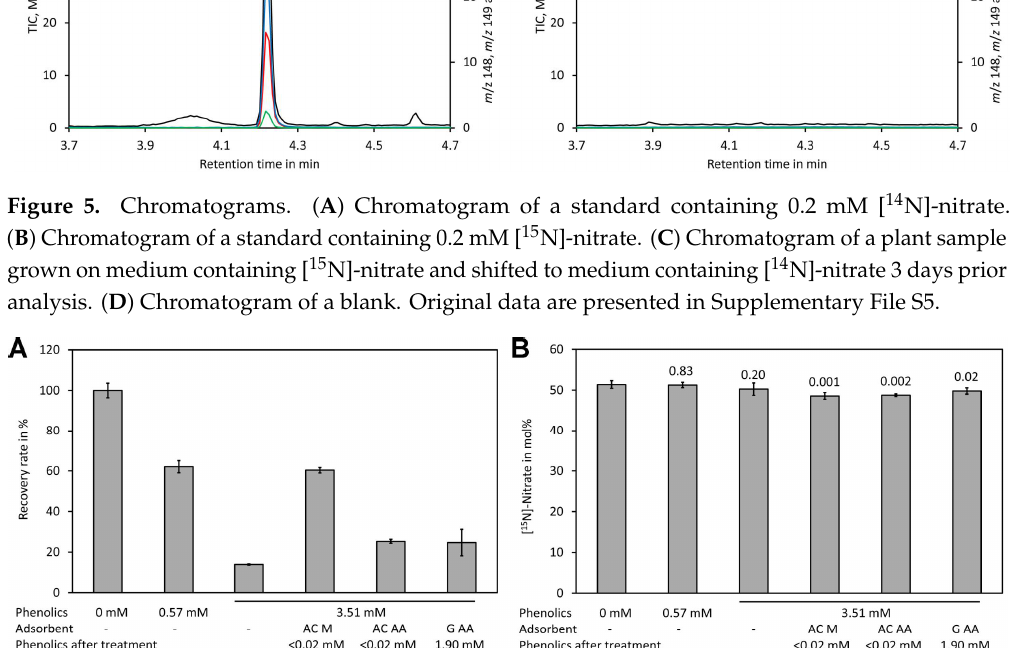
Figure 6. Matrix e ff ect of plant leaf extracts. ( A ) Samples containing di ff erent levels of phenolic compounds (measured in mM ferulic acid equivalents) were spiked with a mixture containing [ 14 N]-nitrate and [ 15 N]-nitrate to a final concentration of 0.4 mM total nitrate and treated with the indicated absorbents. Subsequently, the residual phenolics and the recovery rate of total nitrate were assayed using DNT as the internal standard. ( B ) The [ 15 N]-nitrate levels of the same samples shown in ( A ). Original data are presented in Supplementary File